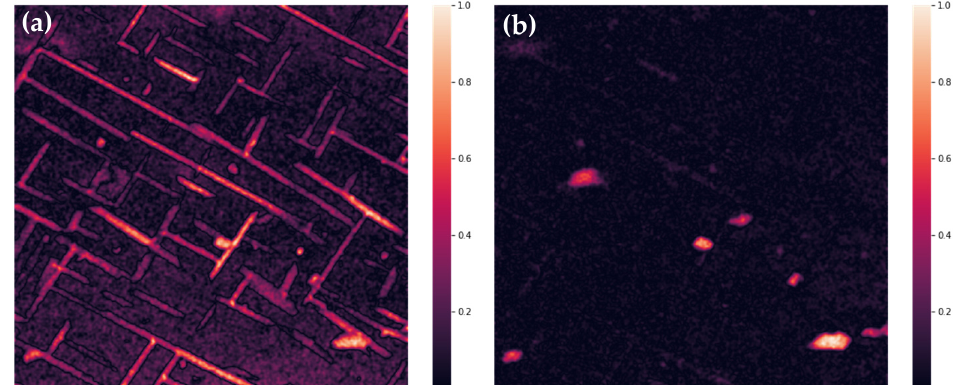
Figure 10. Summed and normalized intensities for images 3rd ( a ) and 4th ( b ) of final set of images.